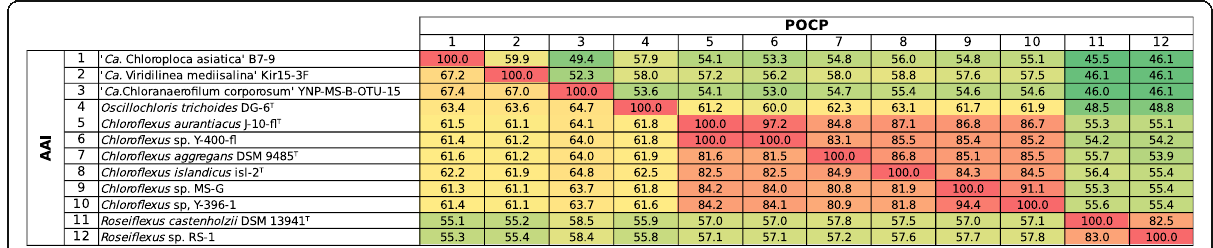
Fig. 3 Results of the analysis of average amino acid identity (AAI) and percentage of conserved proteins